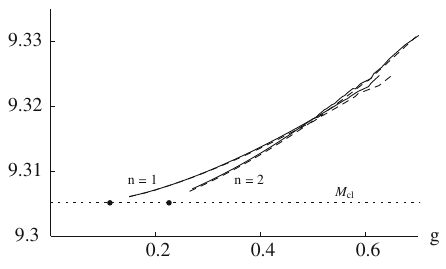
for the first two positive energy levels and the dashed ones for the first two negative energy levels. The dotted line corresponds to the soliton mass in the background model. The two black dots are the points with specific values of g for which the represented bound states first